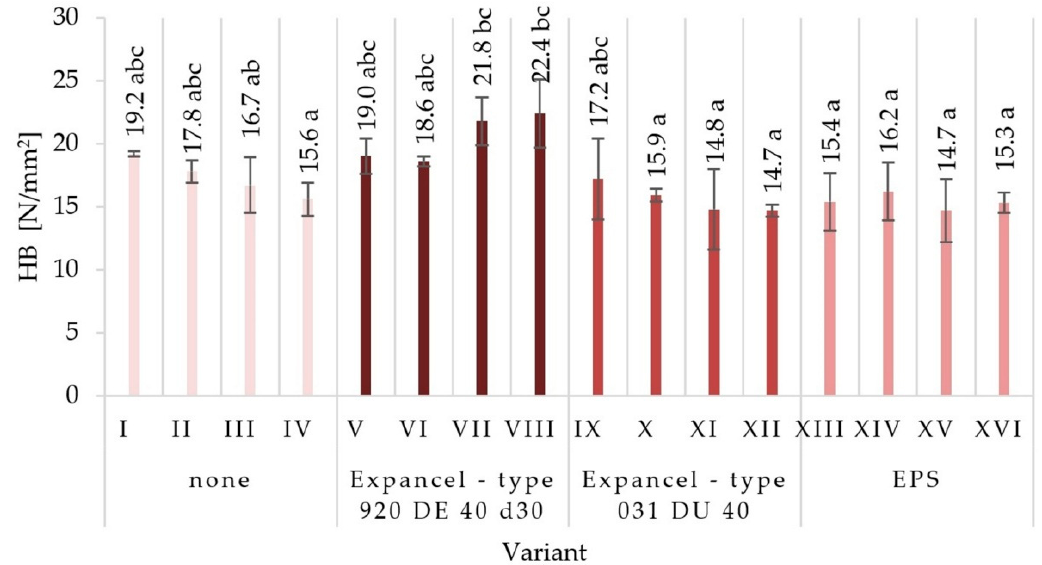
Figure 8. Surface hardness (HB) of the particleboards produced (means and standard deviation, a, b, c, (…). Homogeneous groups were determined by the Tukey test; different letters denote a significant difference; means followed by the same letter do not statistically differ from each other).